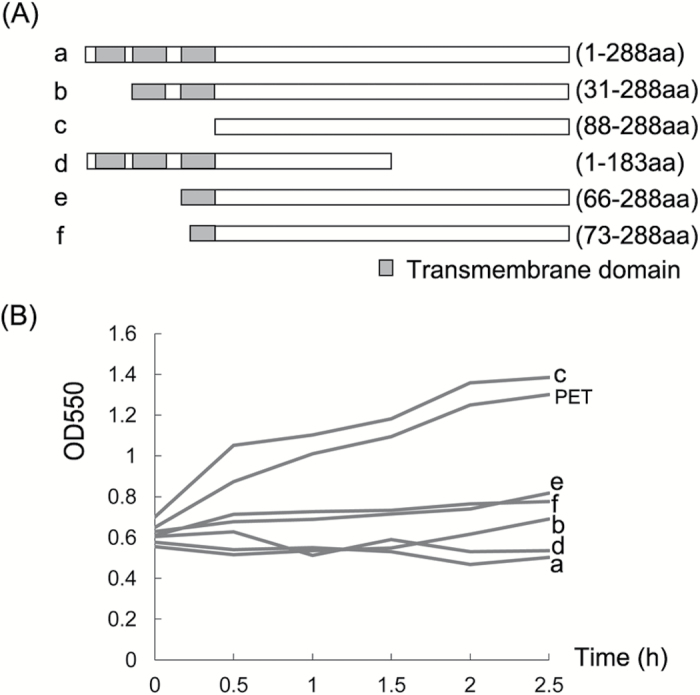
The cytotoxic region of the CMS-associated gene orf288. (A) Truncated orf288 with different transmembrane domains: (a) full-length DNA sequence with three transmembrane domains; (b) truncated orf288 without the first transmembrane domain; (c) truncated orf288 without any transmembrane domains; (d) truncated orf288 that does not include 105-aa at the C-terminus; (e) truncated orf288 with only the third transmembrane domain; and (f) truncated orf288 with only part of the third transmembrane domain. (B) Effect of the overexpression of different truncated orf288 fragments on the growth of E. coli cells: (a–f) indicate the different truncated fragments shown in (A). IPTG was added when cell growth reached an OD550 of 0.6. PET indicates the control expression vector induced by IPTG.